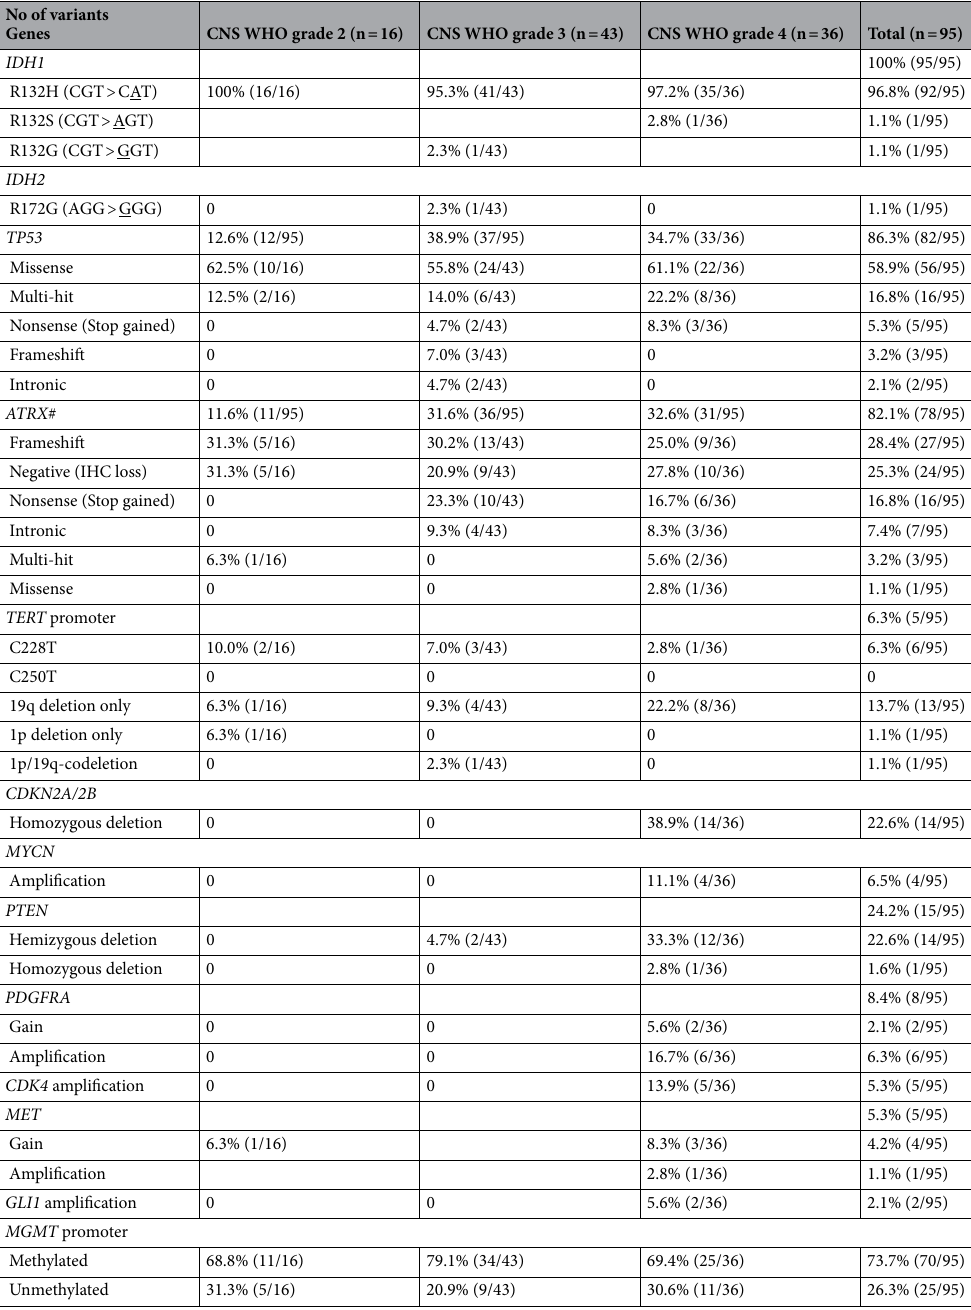
Table 3. Genomic alterations found in astrocytoma, IDH-mutant in this study. IHC immunohistochemistry. # No novel mutation was